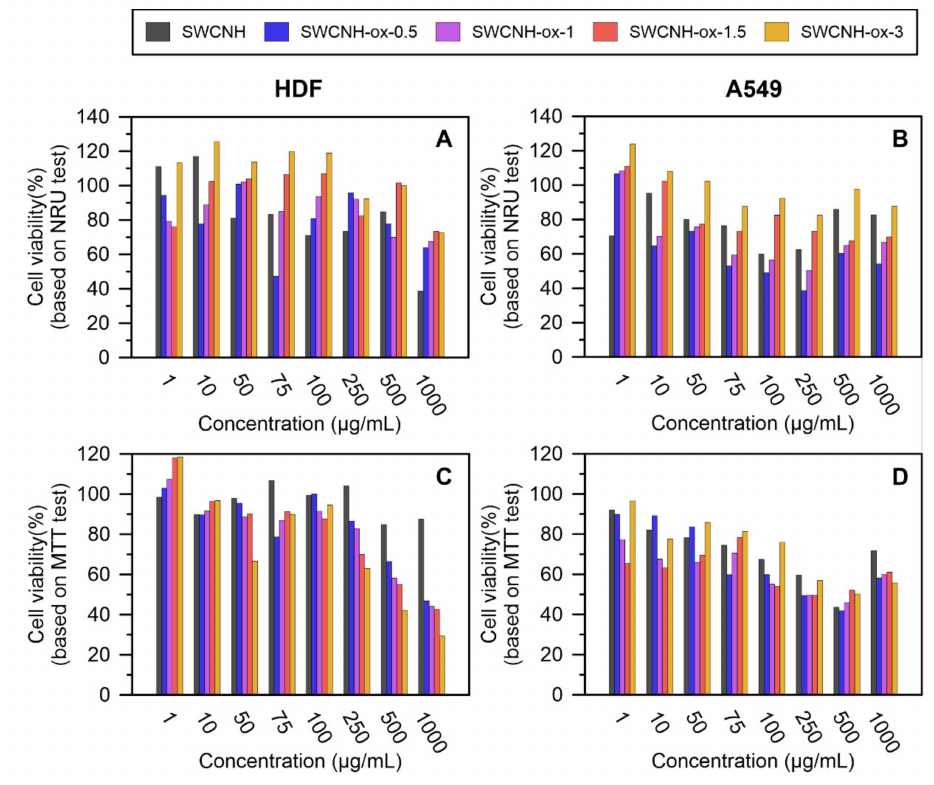
Figure 5. The results of in vitro experiments ( A ) Neutral Red Uptake (NRU) on human dermal fibroblasts (HDF), ( B ) NRU on A549, ( C ) 3-(4,5-dimethylthiazol-2-yl)-2,5-diphenyltetrazolium bromide (MTT) on HDF, and ( D ) MTT on A549 with SWCNH and SWCNH-ox